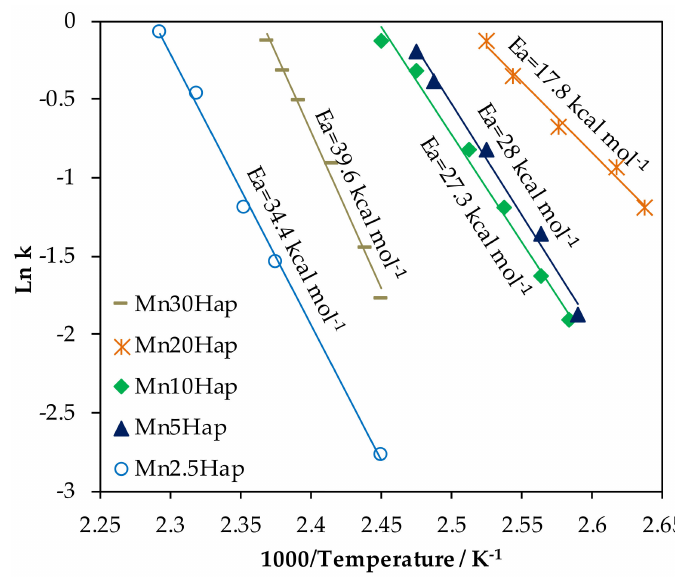
Figure 9. Arrhenius plots for HCHO oxidation over MnxHap catalysts. Table 5. Catalytic performances over MnOx based catalysts given in the